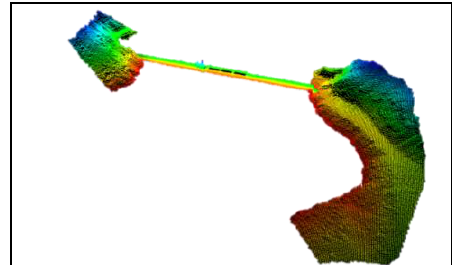
Figure 6 . MDL Mobile scanner point cloud